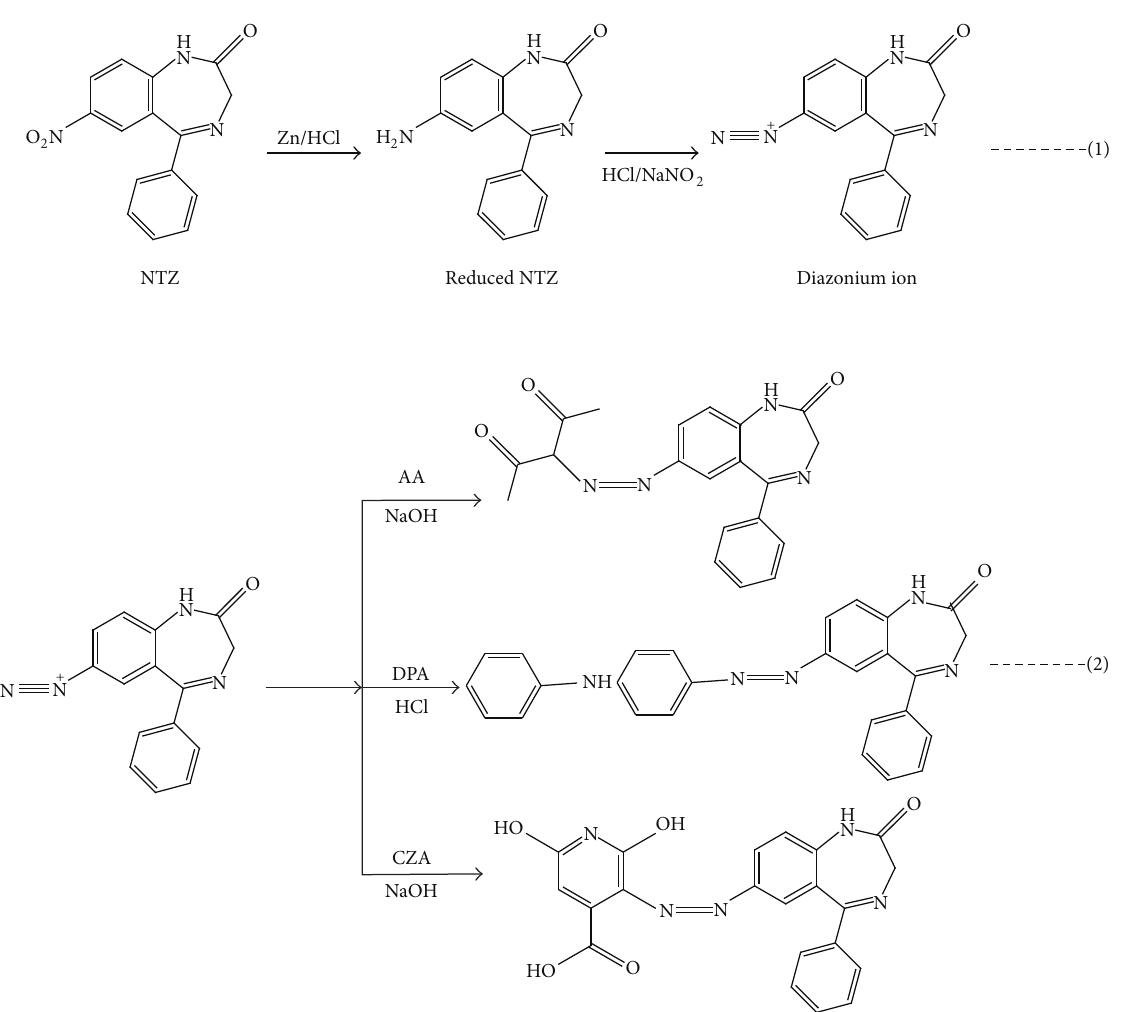
S 1: Proposed reaction scheme for NTZ (1) diazotization (2) coupling reaction.